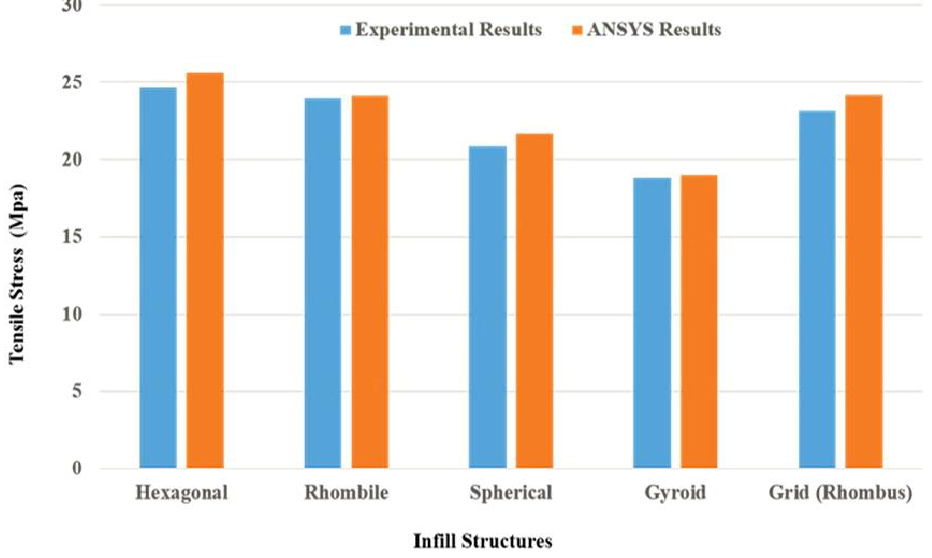
Figure 5. Tensile stress for various infill structures. This indicates the similarity of yield stress observed in the hexagonal infill structure (honeycomb) which possesses 13.79 MPa of ultimate tensile strength. From other infills, it was found that the hexagonal infill structure holds good tensile properties. The pattern of increasing yield strength is observed in all infill structures proportionately to the weight of the material being increased. Spherical and gyroid infill structures show lower tensile values due to the infill material bonding strength [40,41]. The area of contact between the patterns in the infill is smaller compared with that of the honeycomb structures. This phenomenon leads to a decrease in bond strength and the lowest tensile strength. The gyroid structure infill has 8.56 MPa of ultimate tensile strength for the same infill ratio, while the hexagonal structures possess 13.79 MPa of yield strength [42].